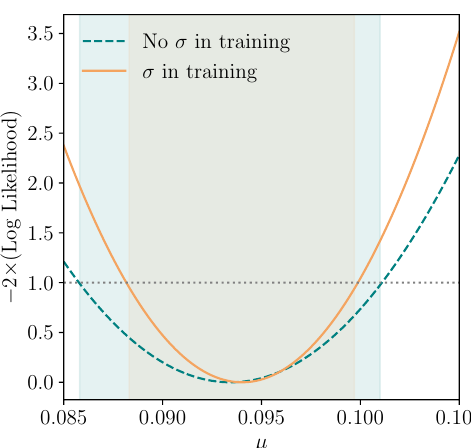
Figure 5: A determination of the signal strength µ using a classifier trained with or without σ , where σ is uniformly distributed between 0 and 0.29. The true value of µ is 0.1 and | Y | = 10 4 . The shaded regions indicate the ranges where the curves intersect unity (the 68% confidence